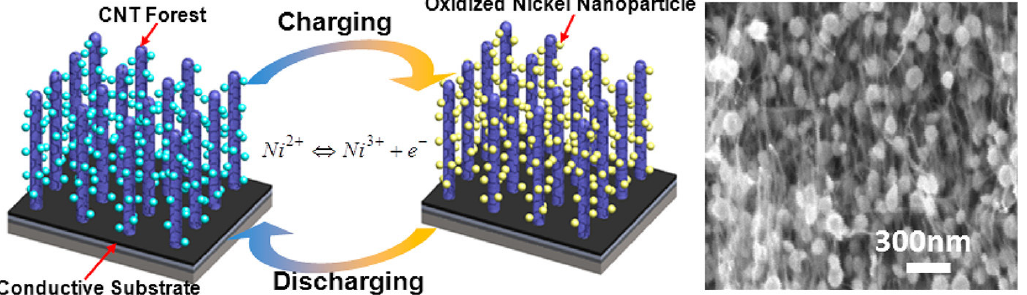
Figure 13. A schematic illustration of the experimental techniques used to create 3D mesoporous hybrid CNT/oxide architectures and 3D mesoporous metal oxide structures. Reproduced with permission from [88].